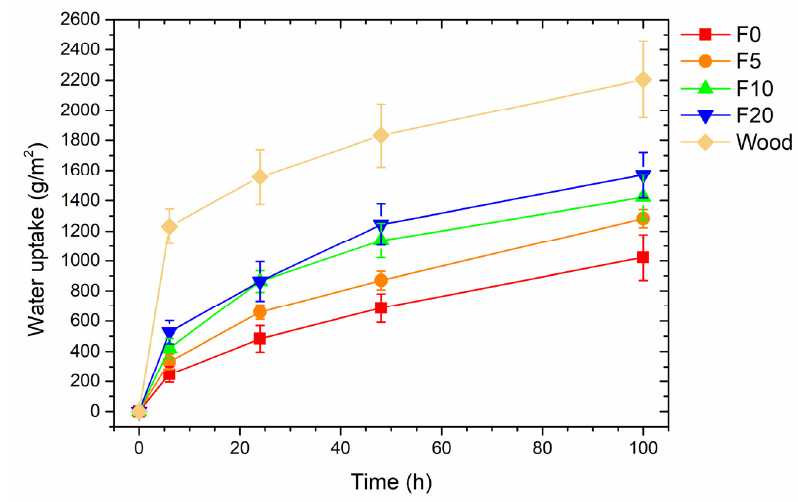
Figure 10. Evolution of the water uptake during the test.